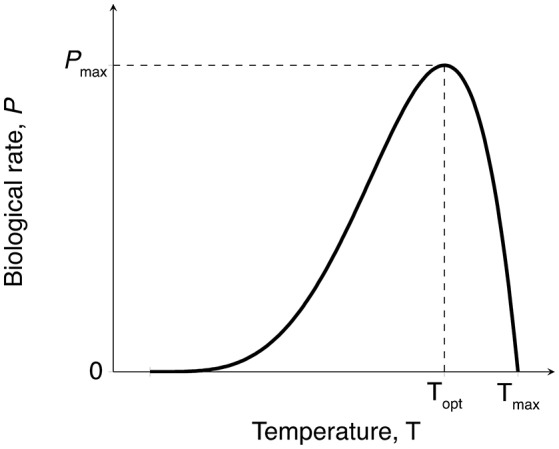
Expected temperature-dependence of gross photosynthesis and respiration rates for seagrass. Biological rates with this temperature-dependence can be fitted to the empirical model shown in Equation (1) to obtain maximum metabolic rates (Pmax), thermal optima (Topt), and maximum temperature (Tmax).